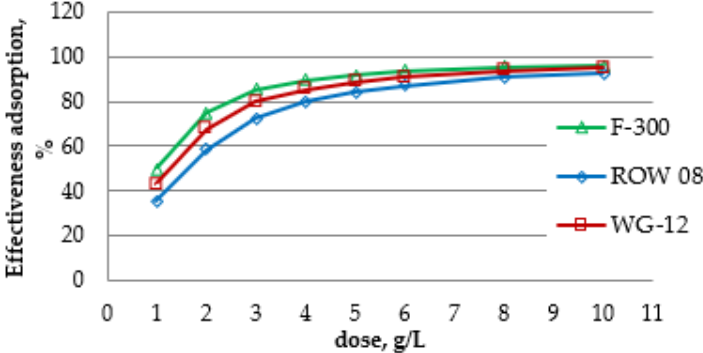
Figure 5. Effect of activated carbon dose on adsorption efficiency.